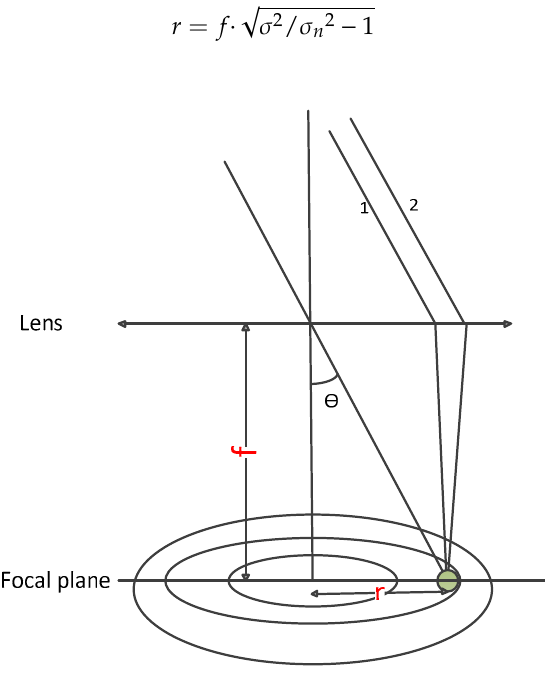
Figure 3. Geometry of the detector for the off-axis position.